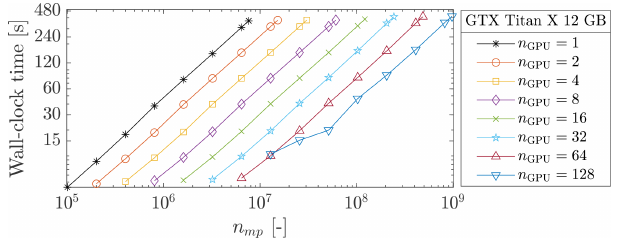
Figure 15. Wall-clock time for one, two, four and eight Tesla V100 GPUs.